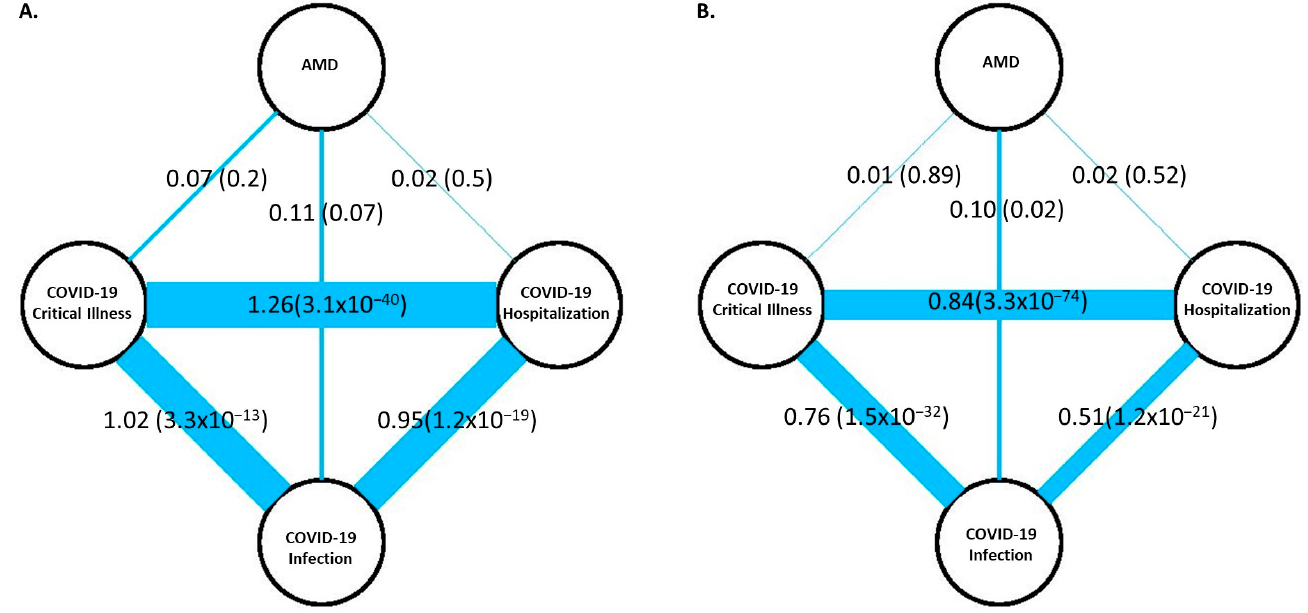
Figure 1. Genetic correlations between AMD and three COVID-19 outcomes, including critical illness, hospitalization, and infections, which were computed by ( A ) LDSC and ( B ) GNOVA. Line width is proportional to genetic correlations between the four phenotypes. The numbers show the genetic correlations and p ‐ values amongst the phenotypes.